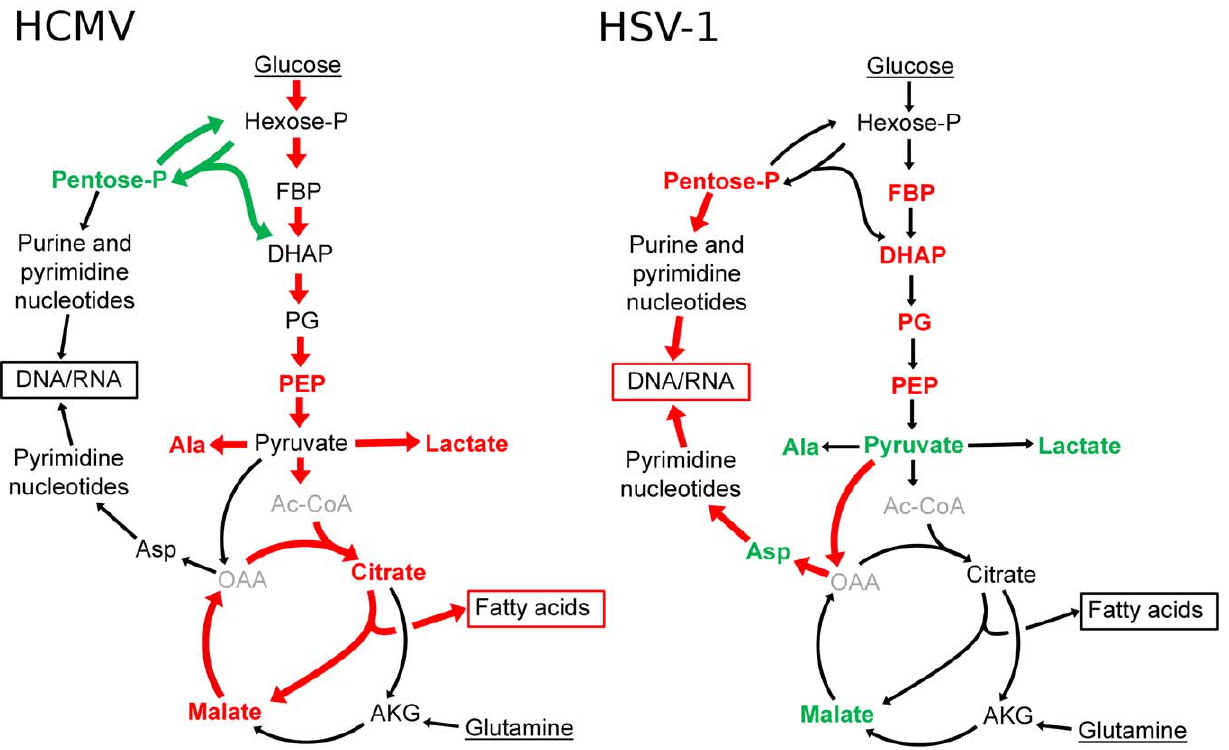
Figure 8. Divergent effects of HCMV and HSV-1 on central carbon metabolism. Schematic summary of major metabolite concentration and flux changes in response to HCMV (left panel) and HSV-1 (right panel) infection of growth arrested fibroblasts. Arrow colors denote flux changes and font colors denote metabolite level changes relative to the mock-treated control (red-increased, green-decreased, grey-not detected). (Hexose-P: glucose-6-phosphate and its isomers, Pentose-P: ribose-phosphate and its isomers, FBP: fructose-1,6-bisphosphate, DHAP: dihydroxy acetone- phosphate, PEP: phosphoenolpyruvate, Asp: aspartate, Ala: alanine, Gln: glutamine, AKG: oxoglutarate, OAA: oxaloacetate, Ac-CoA: acetyl- coenzymeA.)